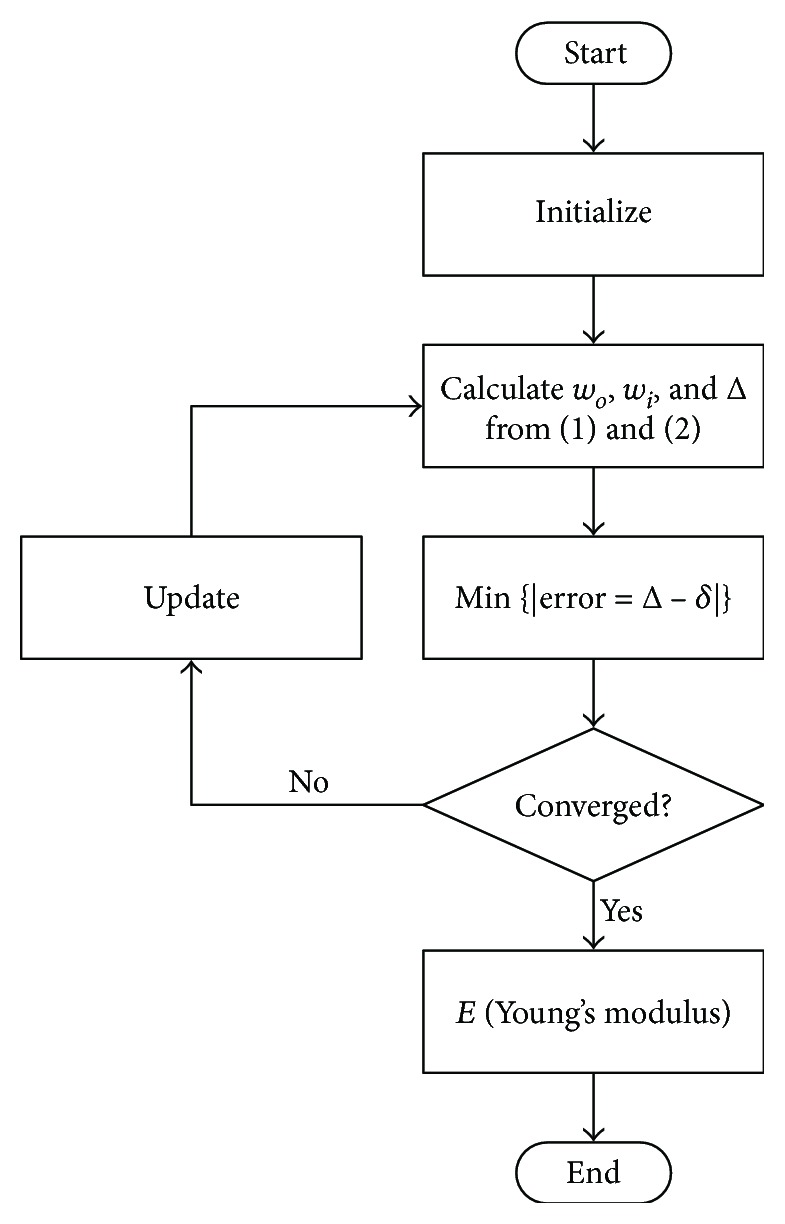
Flowchart for corneal Young's modulus estimation.